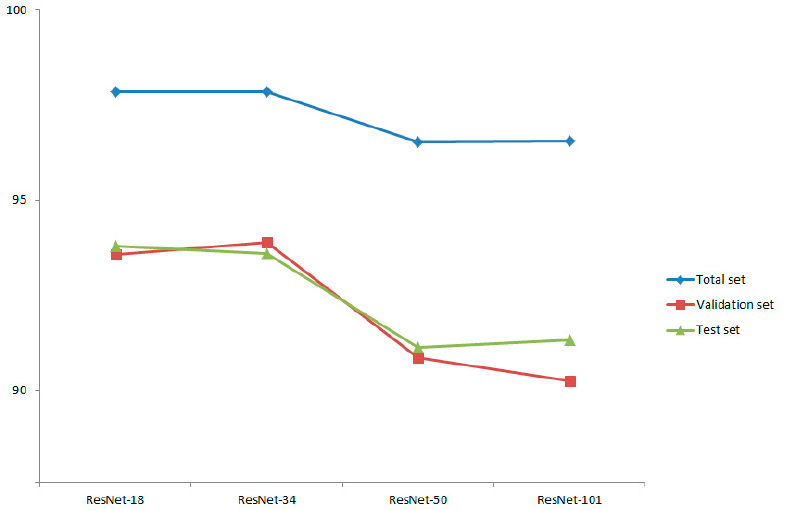
Figure 4. Prediction accuracy of the four models: success rate of total set (blue line), validation set (red line), and test set (green line).